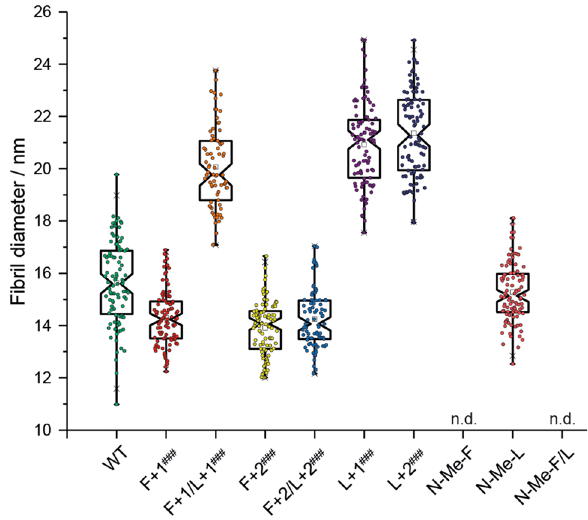
Figure 4. Box plot showing the diameters of fibrils formed from all Aβ 40 peptide variants determined based on TEM images. N -Me-F and N -Me-F/L do not fibrillate (n.d. means not determined); minor second fibril population of F+1/L+1 and F+2/L+2 not shown. Significance was tested applying a heteroscedastic Student’s t-Test using two-tailed distributions, # p ≤ 0.05; ## p ≤ 0.01; ### p ≤ 0.001 vs WT .